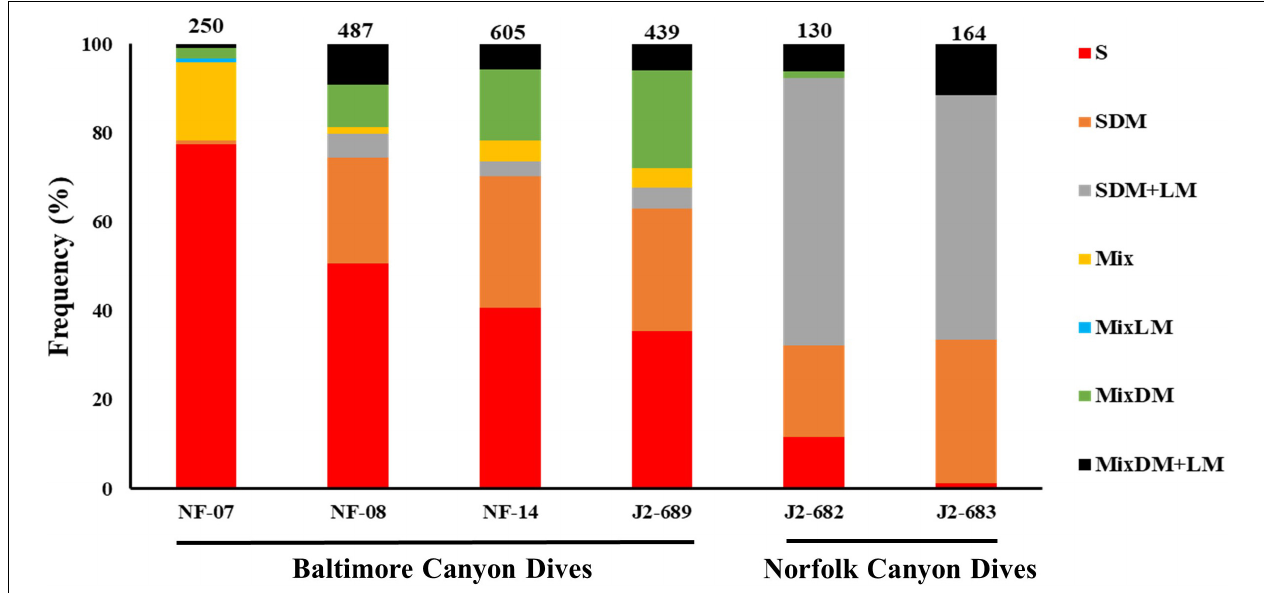
FIGURE 3 | Distribution (%) of the types of habitats across the six remotely operated vehicle (ROV) dives in Baltimore (NF-07, NF-08, NF-14, and J2-689) and Norfolk canyons (J2-682 and J2-683). The number of video frames processed from each ROV dive is shown above each bar. Habitat types: sand-mud (S), sand mixed with dead mussels (SDM), sand with dead and live mussels (SDM+LM), mixed hard-soft (Mix), mixed hard-soft with dead mussels (MixDM), mixed hard-soft with live mussels (MixLM), mixed hard-soft with dead and live mussels (MixDM+LM).